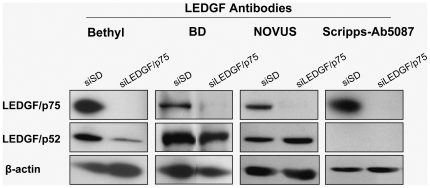
Identification of LEDGF/p75 specific antibody by immunoblotting in PC-3 cells with transient LEDGF/p75 knockdown.Cells were transfected with siLEDGF/p75 to induce transient knockdown of LEDGF/p75. PC-3 cells transfected with small interfering scrambled RNA duplex (siSD) served as corresponding control. Immunoblotting analysis tested the specific reactivity of all the antibodies against LEDGF/PSIP1. All the blot pairs (siSD and siLEDGF/p75) for each antibody were derived from the same blot.